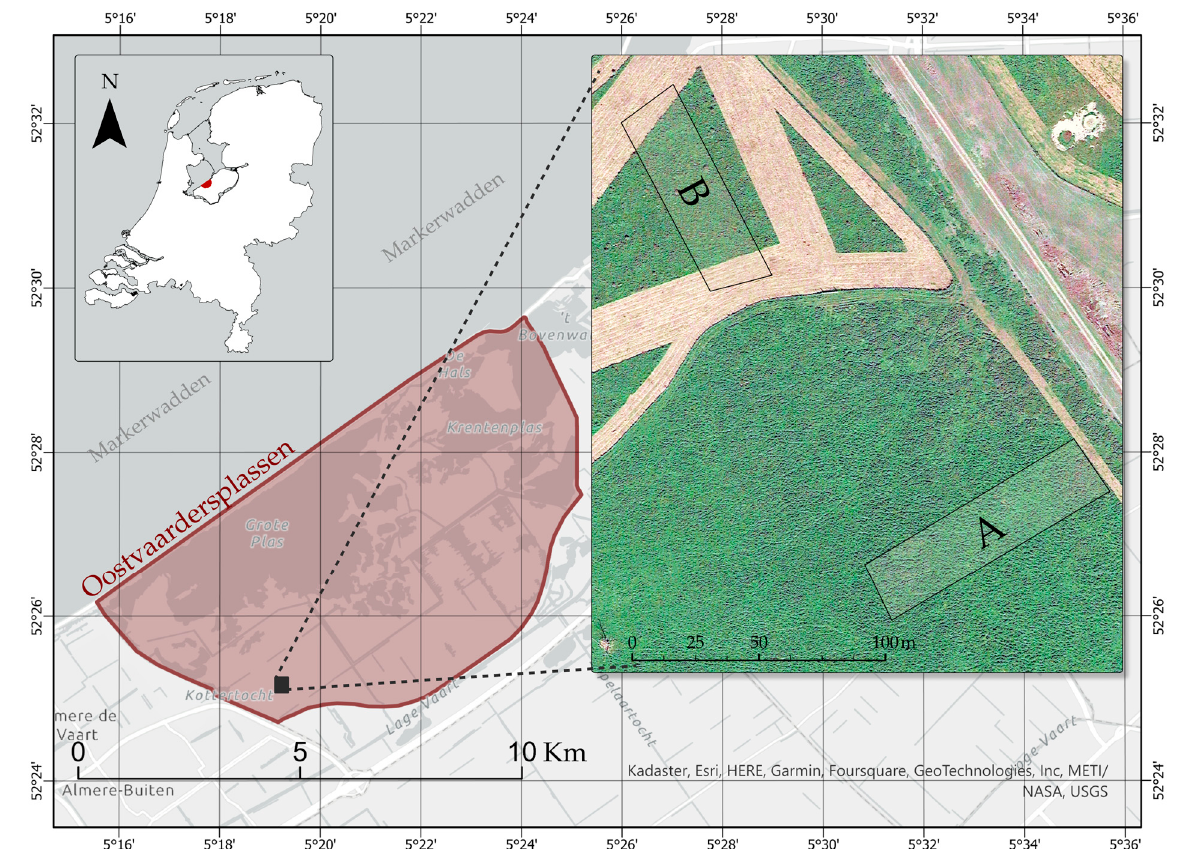
Figure 1. The two areas A and B in the nature reserve Oostvaardersplassen were selected for handheld LiDAR surveys and vegetation sampling. The aerial backdrop image is from Google Earth. Area B was mowed in the summer of 2021 as a management measure for planting shrubs and trees.